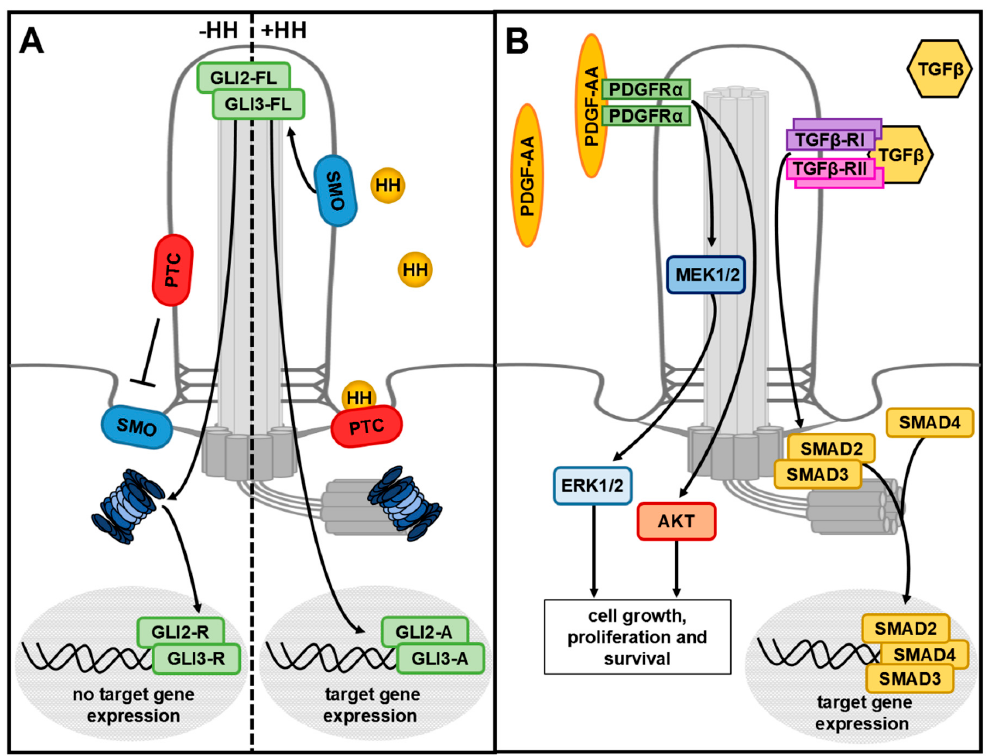
Figure 2. Cilia-mediated HH, PDGFR α and TGF β signalling. ( A ) Without the HH ligand, the receptor PTC inhibits ciliary entry of SMO. GLI2-FL and GLI3-FL are proteolytically processed into the repressor forms GLI2-R and GLI3-R by the ciliary proteasome. They translocate into the nucleus and inhibit HH target gene expression. In the presence of HH, HH binds to its receptor PTC and the HH/PTC complex leaves the cilium. SMO enters the cilium and GLI2-FL and GLI3-FL become activated and, in turn, initiate HH target gene expression. ( B ) PDGF-AA binds to the ciliary receptor PDGFR α and activates AKT signalling or the MEK1/2–ERK1/2 signalling cascade. TGF β binds to a heterotetrameric receptor composed of TGF β -RI and TGF β -RII in the ciliary membrane. At the base of cilia, the signal is transduced via different SMAD proteins.